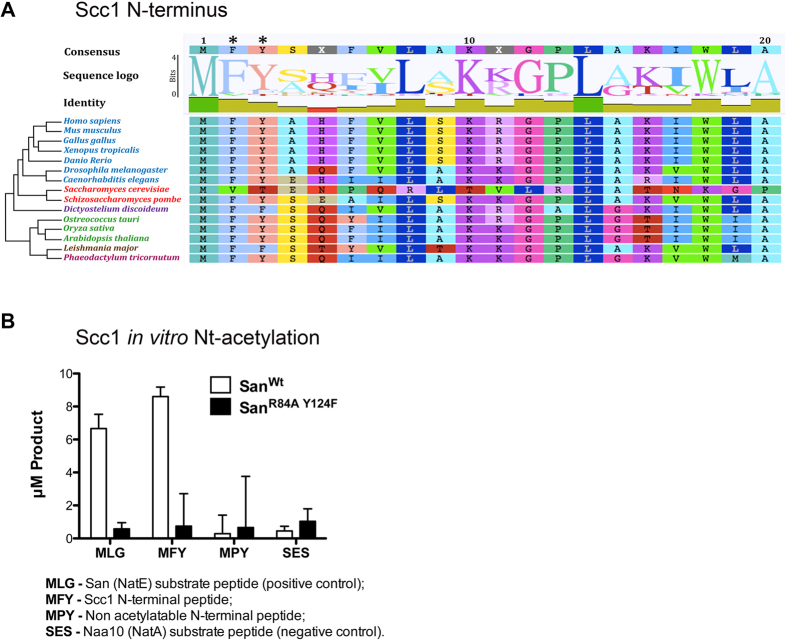
Naa50/San N-terminally acetylates Scc1.The N-terminal phenylalanine and tyrosine residues of Scc1 are highly conserved. The Scc1 N-terminal sequence (MFY-) is efficiently Nt-acetylated in vitro by Naa50/San. (A) Orthologs of Scc1 from 15 distinct species representative of the eukaryotic tree of life were retrieved using reciprocal bidirectional protein BLAST analysis. N-terminal sequences were aligned using the Geneious R7 software. The N-terminal second residue phenylalanine (F) and third residue tyrosine (Y) are highly conserved across the eukaryotic tree of life (see asterisks). The height of the letters represents the overall relative degree of residue conservation. (B) Wild-type Drosophila Naa50/San efficiently N-terminally acetylated in vitro Scc1 N-terminal peptide (MFY-) and a previously defined Naa50/San substrate MLG- peptide (positive control). In contrast, Naa50/San did not efficiently N-terminally acetylate a Naa10 substrate peptide SES- (negative control), nor the non-acetylatable N-terminal peptide MPY-. A catalytically dead-version of Naa50/San (SanR84A Y124F) failed to efficiently N-terminally acetylate all tested peptides. Both wild type Naa50/San and Naa50/SanR84A Y124F were heterologously expressed in E. coli (see methods). All measurements were done in the linear range of enzymatic activity (data not shown).